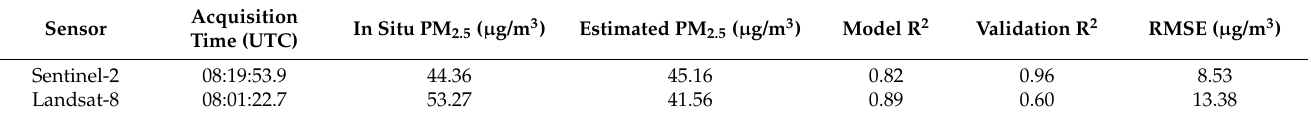
Table 8. Comparison of estimated PM 2.5 based on Sentinel-2 and Landsat-8 images acquired